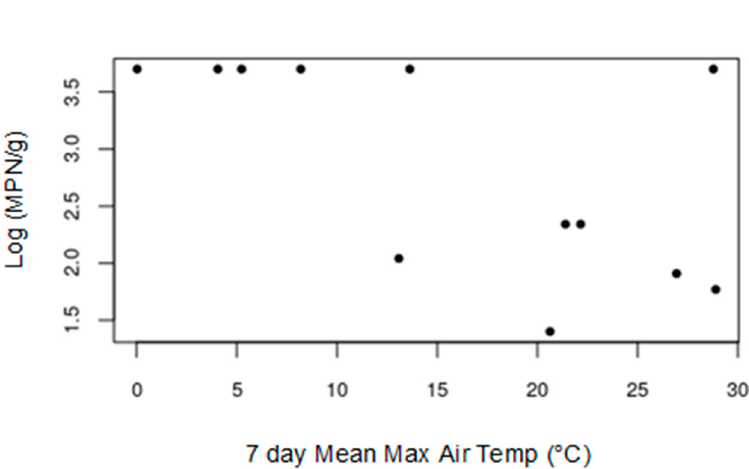
Figure 4. Scatter plot showing relationship between the log(MPN) Xcc detected derived from nested real-time PCR and the mean maximum air temperature in the week prior to